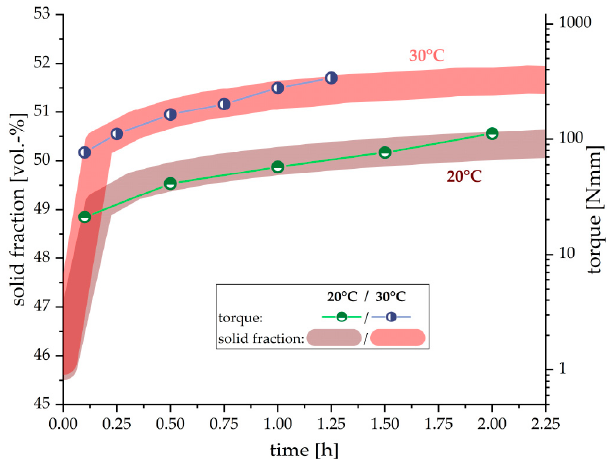
Figure 5. Comparison of the solid fraction of the cement paste (cement & hydrate phases) and the measured torque within the first two hours of hydration at 20 °C and 30 °C (w/c = 0.36). Note that the phase content is linearly scaled whereas the torque is scaled logarithmically. Colored background for solid fraction indicates error margin.